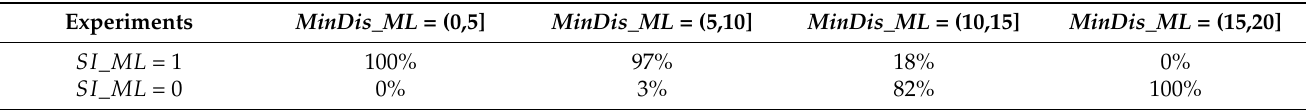
Table 5. Distribution of the classification and regression predictions.